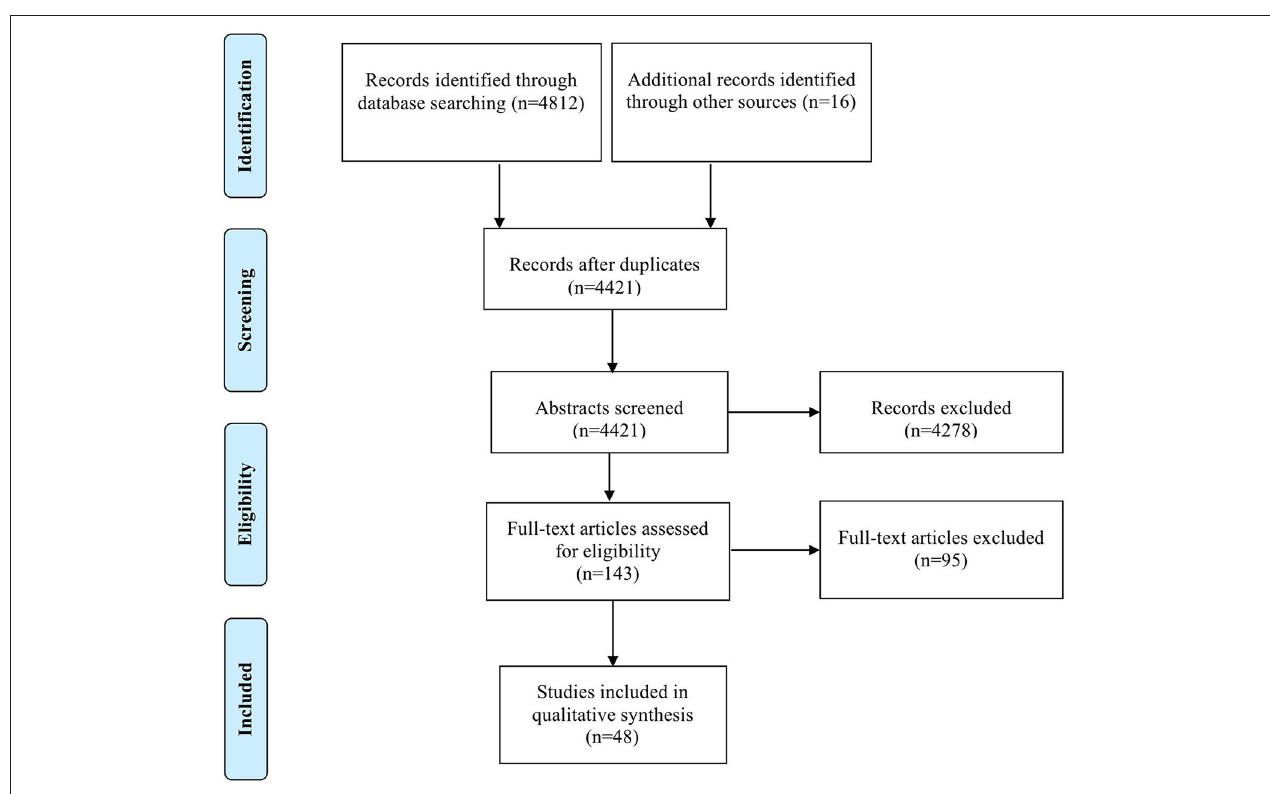
FIGURE 1 | Flow diagram of articles identified and excluded according to PRISMA